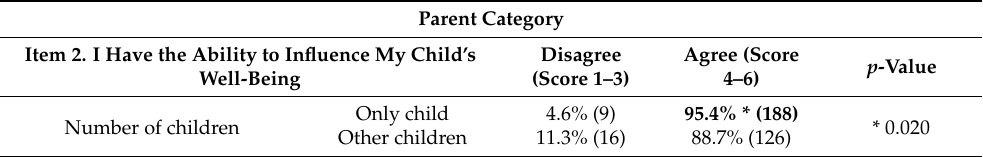
Table 4. Statistically significant correlations between “Parent” category and socio-demographic characteristics.